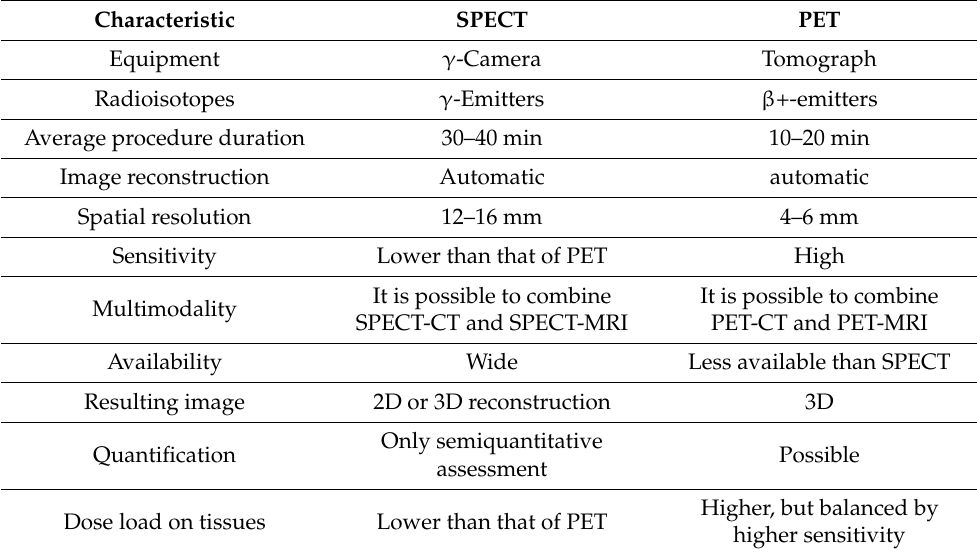
Table 1. Comparative characteristics of SPECT and PET techniques. Characteristic SPECT PET